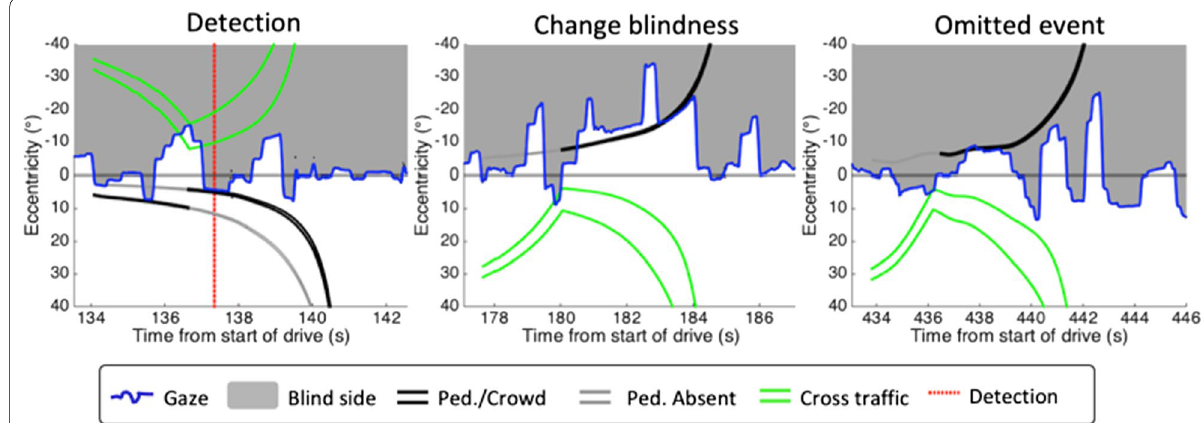
Fig. 4 Examples of event data showing gaze (blue lines) and eccentricities of the critical pedestrian (black lines) and extent of the cross-traffic (green lines). In each example, an individual with left HVFL (gray area) has triggered the critical pedestrian. The pedestrian eccentricity prior to appearing is represented as a gray line. That location is visible in a seeing part (white area) of the visual field before and after the appearance in the left and middle panels, but not in the right panel. In the first example (left), representing Condition B, the individual looks at the cross-traffic, triggering the pedestrian far from the crosswalk to disappear and the appearance of the critical pedestrian near the crosswalk. The participant indicates that they detected the pedestrian appear (red dotted line). In the second example (middle), representing Condition A, the pedestrian is triggered, but there is no detection following sight of the pedestrian, and thus, this event was considered change blindness. In the last example (right), representing Condition A, the location of the pedestrian prior to the change was never visible. So, even though they triggered the pedestrian and failed to detect the change, this was not considered change blindness and was omitted from